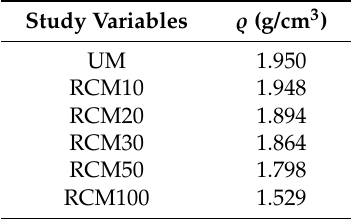
Table 3. Density in hardened state of the RCM.